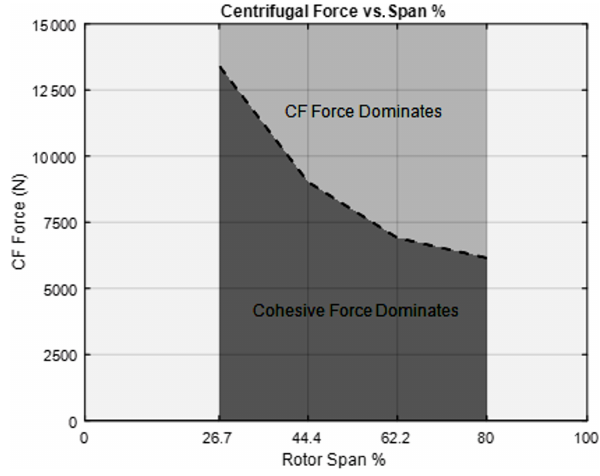
Figure 23. Cohesive failure curve.